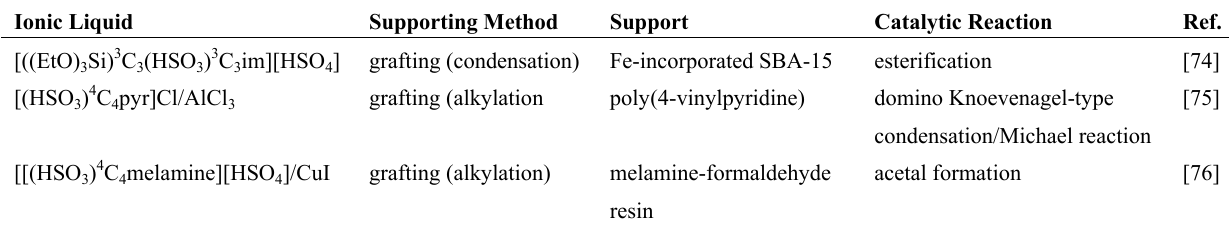
Table 3. Preparation of dual acidic SILPs with both Lewis and Brønsted acidity and their application in catalytic reactions.